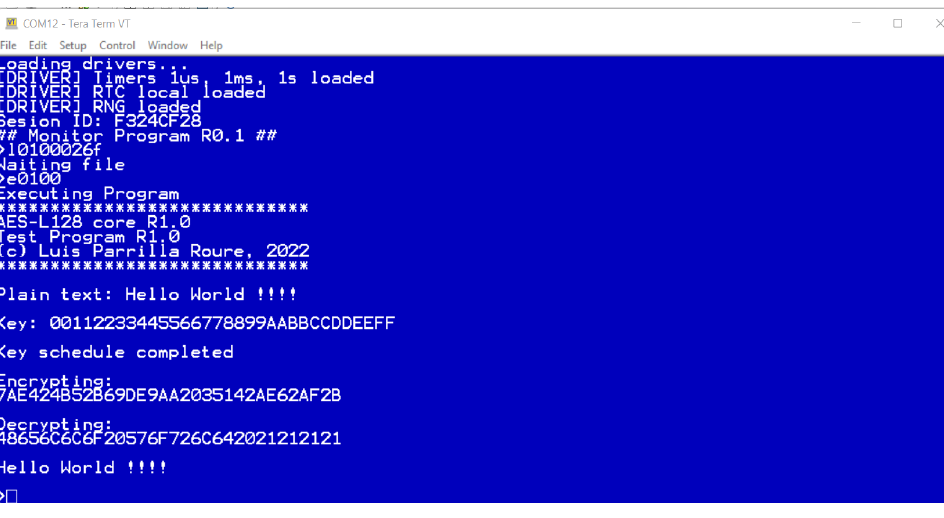
Figure 15. AES co-processor Dracon test program